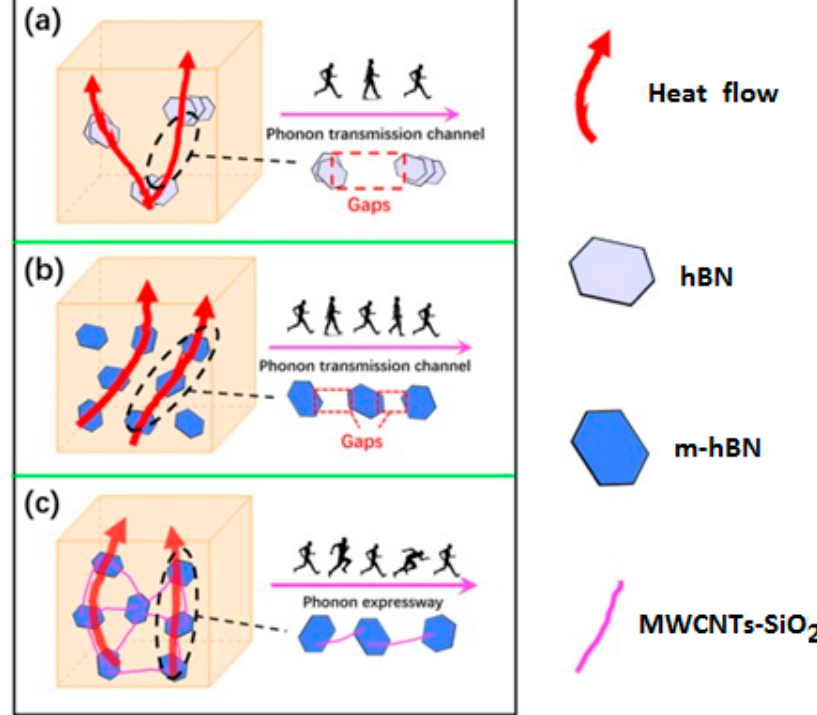
Figure 67. The schematic representation of thermally conductive pathways of ( a ) hBN/PVDF, ( b ) m- hBN/PVDF and ( c ) m-hBN/MWCNT-SiO2/PVDF composites [230]. ( b ) m-hBN/PVDF and ( c ) m-hBN/MWCNT-SiO2/PVDF composites, adapted with permission